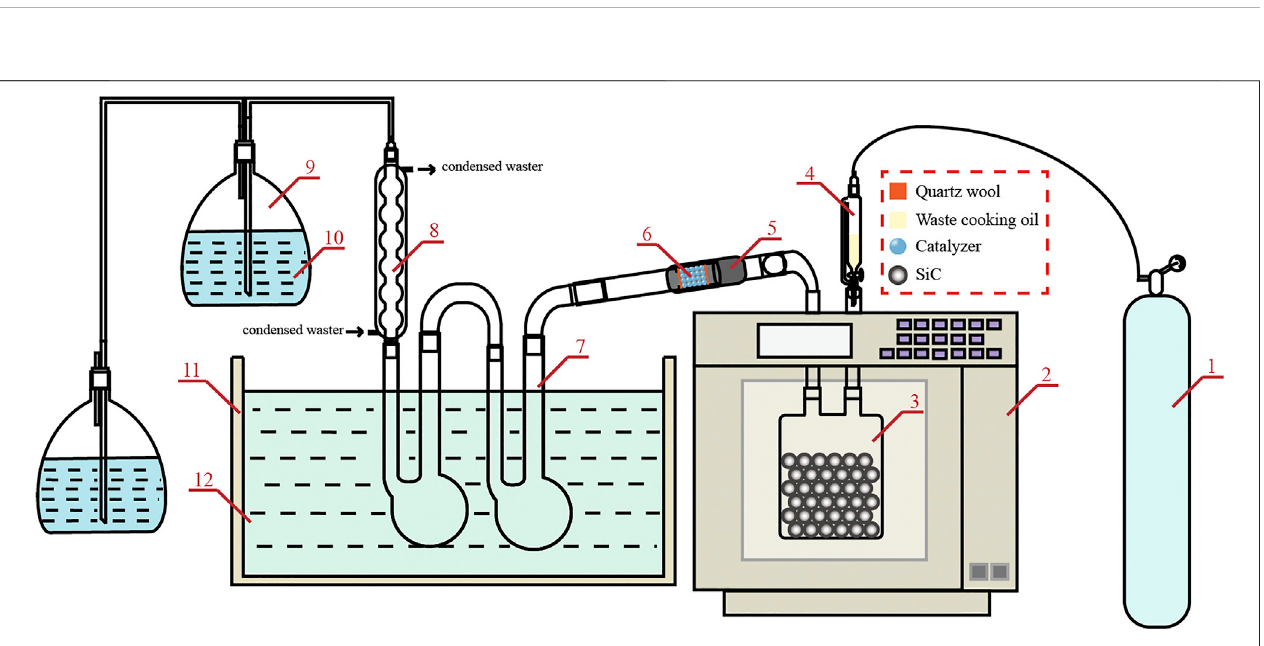
Frontiers in Energy Research |